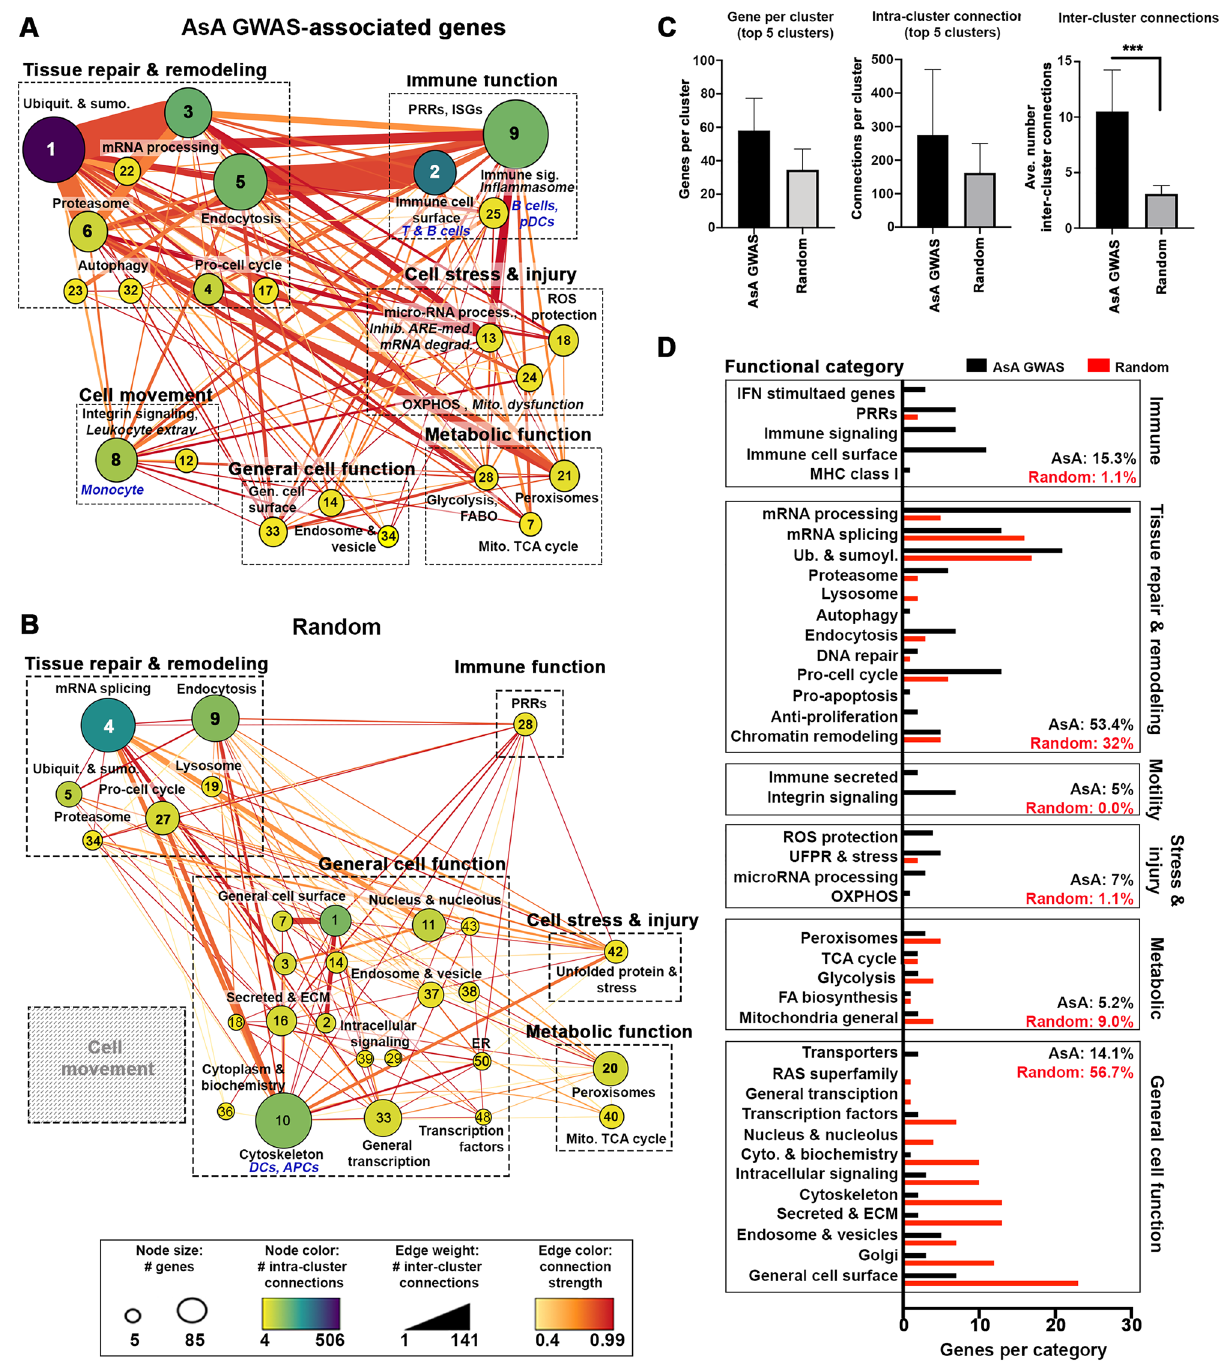
Figure 4. AsA Immunochip-based pathways are supported by summary GWAS from AsA SLE patients. Using SNP-predicted genes from the AsA GWAS validation SNP-set ( A ) or an equivalently sized cohort of random genes ( B ) metastructures were generated based on PPI networks, clustered using MCODE and visualized in Cytoscape. Cluster size indicates the number of genes per cluster, edge weight indicates the number of inter- cluster connections and color indicates the number of intra-cluster connections. Enrichment for each cluster was determined by BIG-C and IPA; clusters were then grouped and categorized according to overall function (immune, tissue repair, metabolic, motility or general). Grey boxes indicate categories lacking relevant clusters. ( C ) Quantitation of cluster size, intra-cluster connections and inter-cluster connections network is displayed. Error bars represent the 95% confidence interval; asterisks (***) indicate a p-value < 0.001 using Welch’s t-test. ( D ) Quantitation of AsA GWAS (black bars) and random (red) genes falling into each BIG-C category and grouped by overall